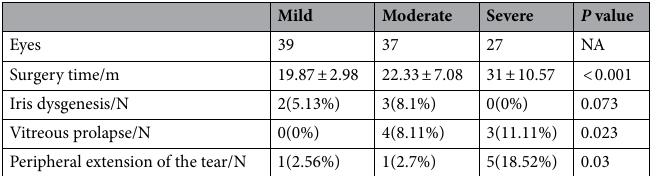
Table 2. Surgery time and intra-operative complications in different degrees of lens subluxation.